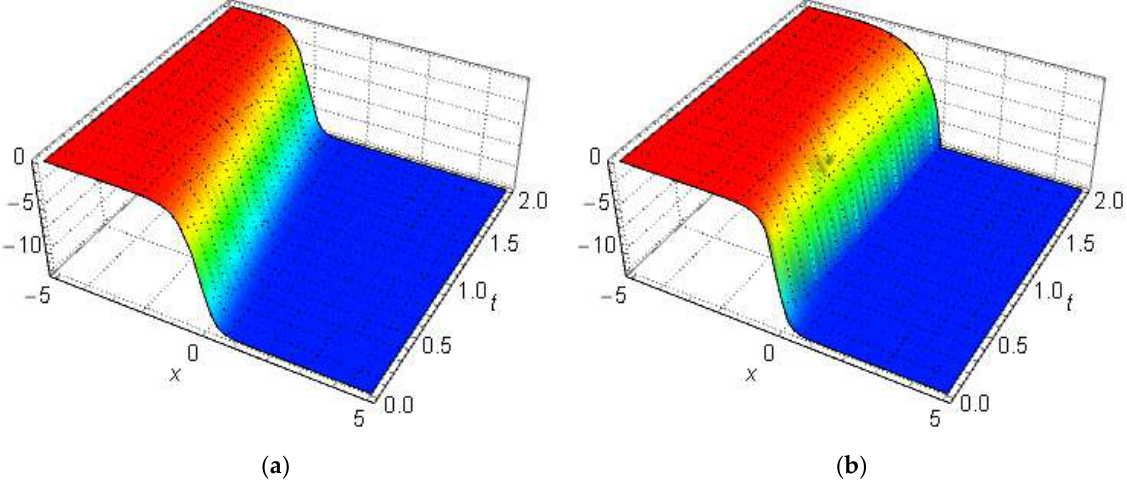
( 𝑥, 𝑡 )(cid:3627) in (32) for (1) at 𝑎 = 0.1, 𝑎 = 1, 𝑎 = 0.05, 𝑞 = 0.1, 𝛼 = 1 2 4 1 1